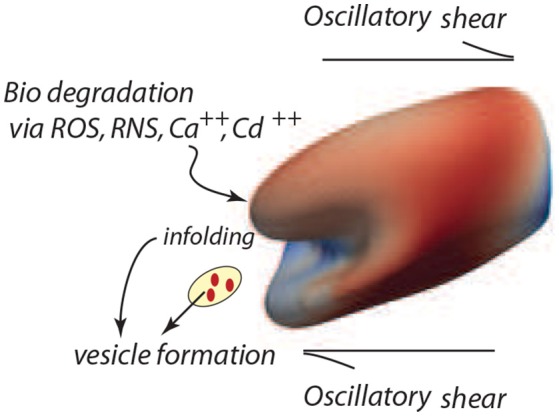
Degradation of the cell's membrane/skeleton attachment structure induces vesiculation under the deformations of oscillatory shear flow as in the case of Figure 3B (upper right frame).